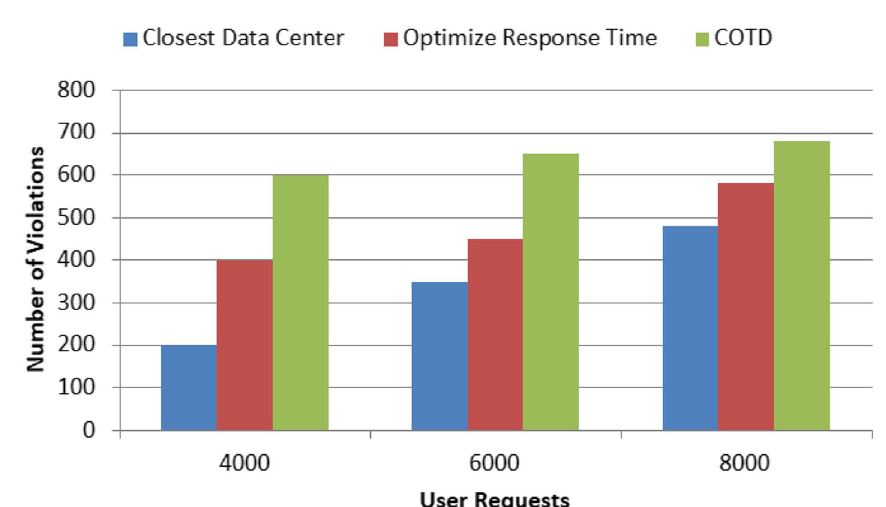
Fig. 13 Comparison of deadline violations with increasing